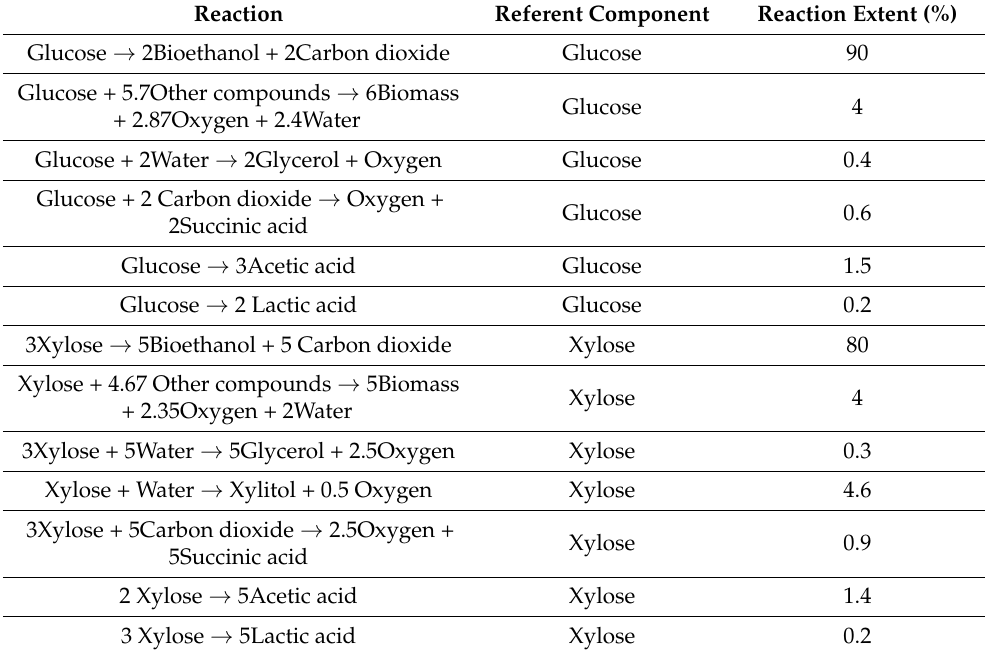
Table 3. Reactions and reaction extents for the fermentation